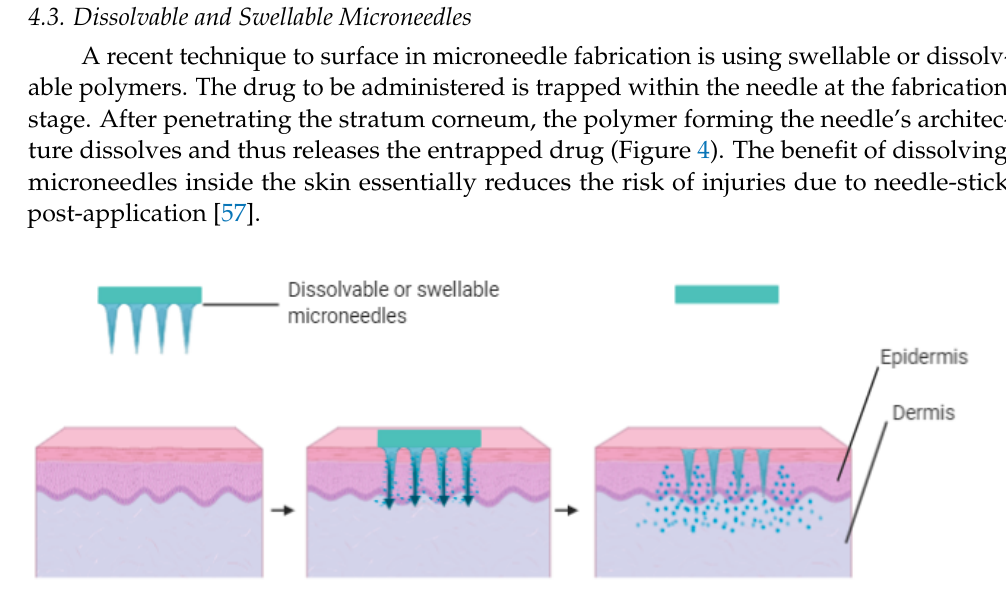
Figure 4. Illustration of poke and release using dissolving or swellable microneedles. Mikszta et al. (2009) stated that swellable microneedles (microneedles that swell after puncture of the skin) are more refined and seek to overcome the low-yield constraints of the dissolvable microneedles [58]. Swellable microneedle patches are based on the struc-